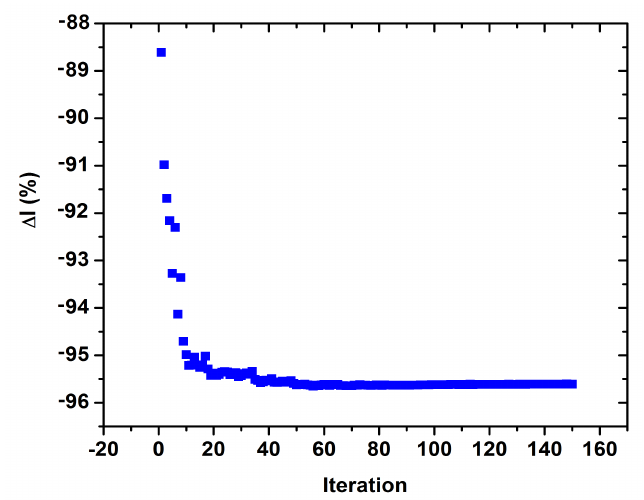
Figure 9. Percentage difference from desired treajectory between the cases of 400 and 900 nm.